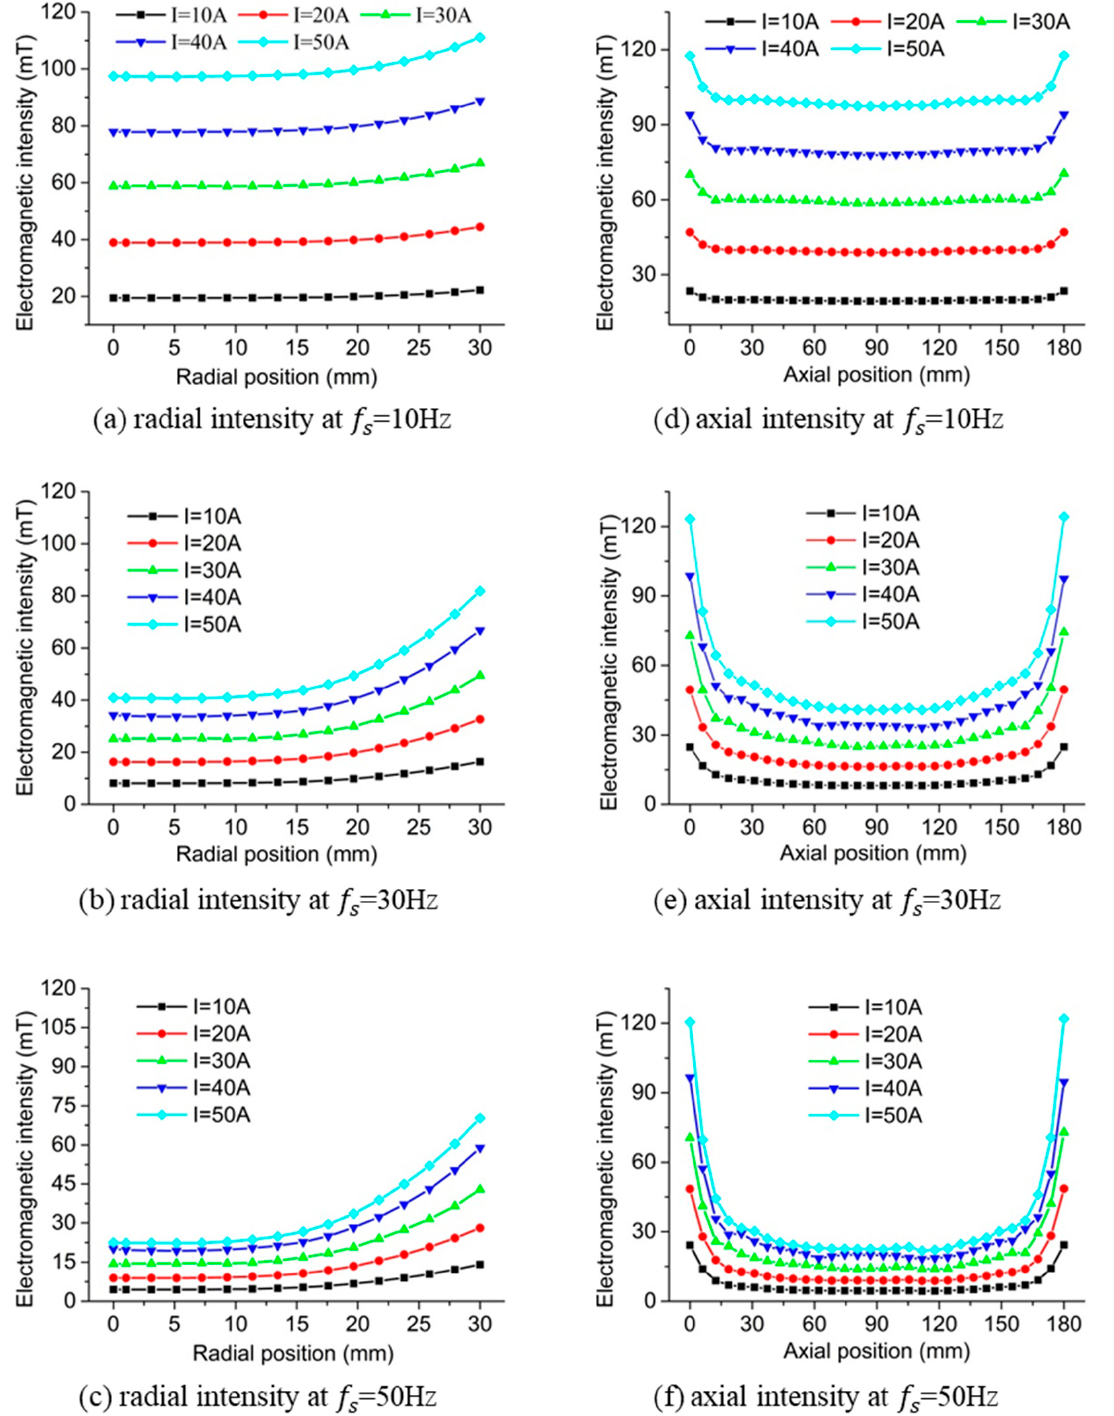
Figure 9. Results of the electromagnetic intensity at di ff erent winding currents and electrical